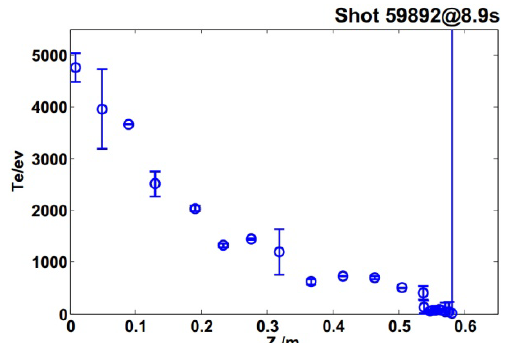
Fig. 14. The radial distribution of electron temperature for the 102s high T e operation on EAST.